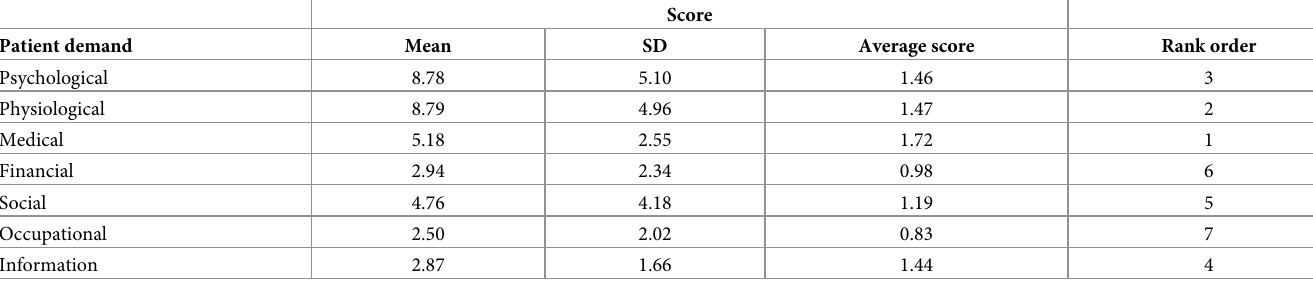
Table 4. Scores and rank for patient demands among all participants (N =